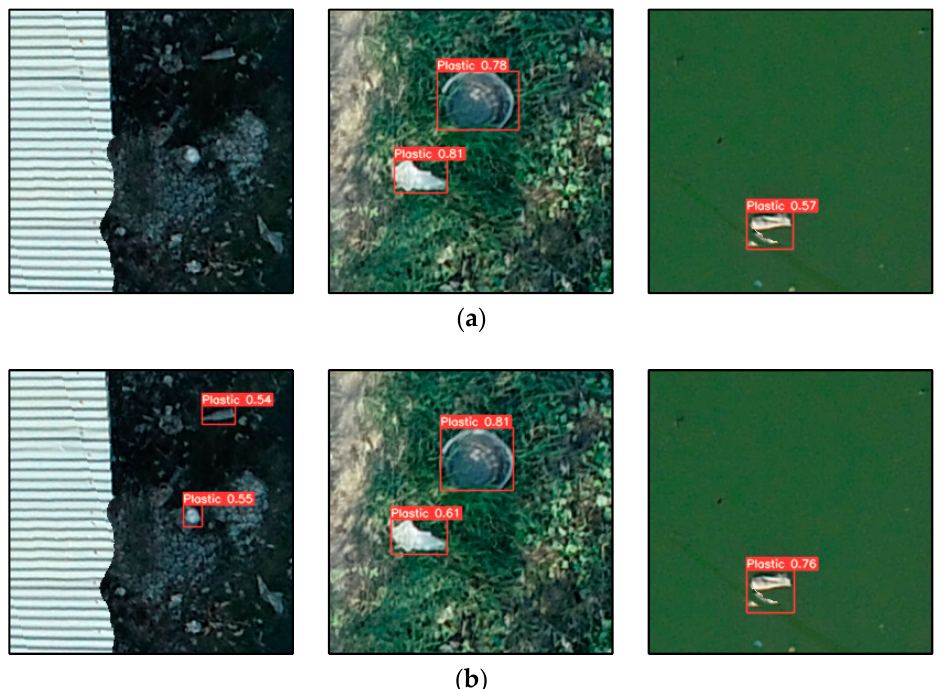
Figure 7. The HMH model fine-tuned on TT performs well in some cases. ( a ) TT model result on TT. ( b ) HMH model results on TT with fine-tuning. (Note: bar-like objects are galvanized stainless steel roof sheets).